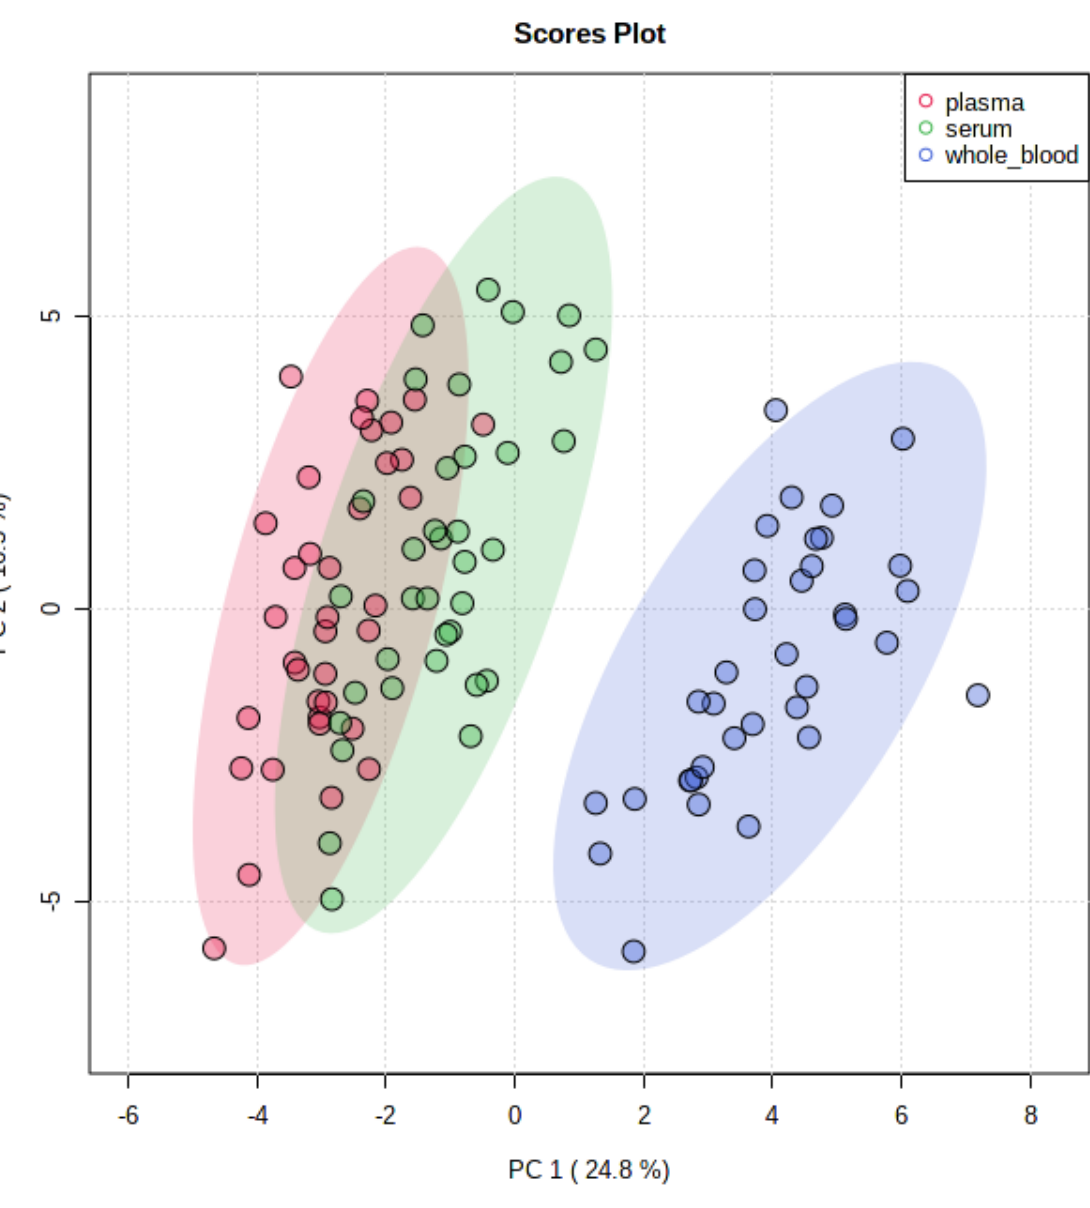
Figure 4. Principal component analysis scores 2D plot of amino acid profiles in whole blood, plasma, and serum. Plot was made using Metaboanalyst 5.0 free online software package and autoscaling of the concentration data. Table 3. Comparison of amino acid concentrations (µM) in whole blood, plasma, and serum of healthy dogs ( n = 36).